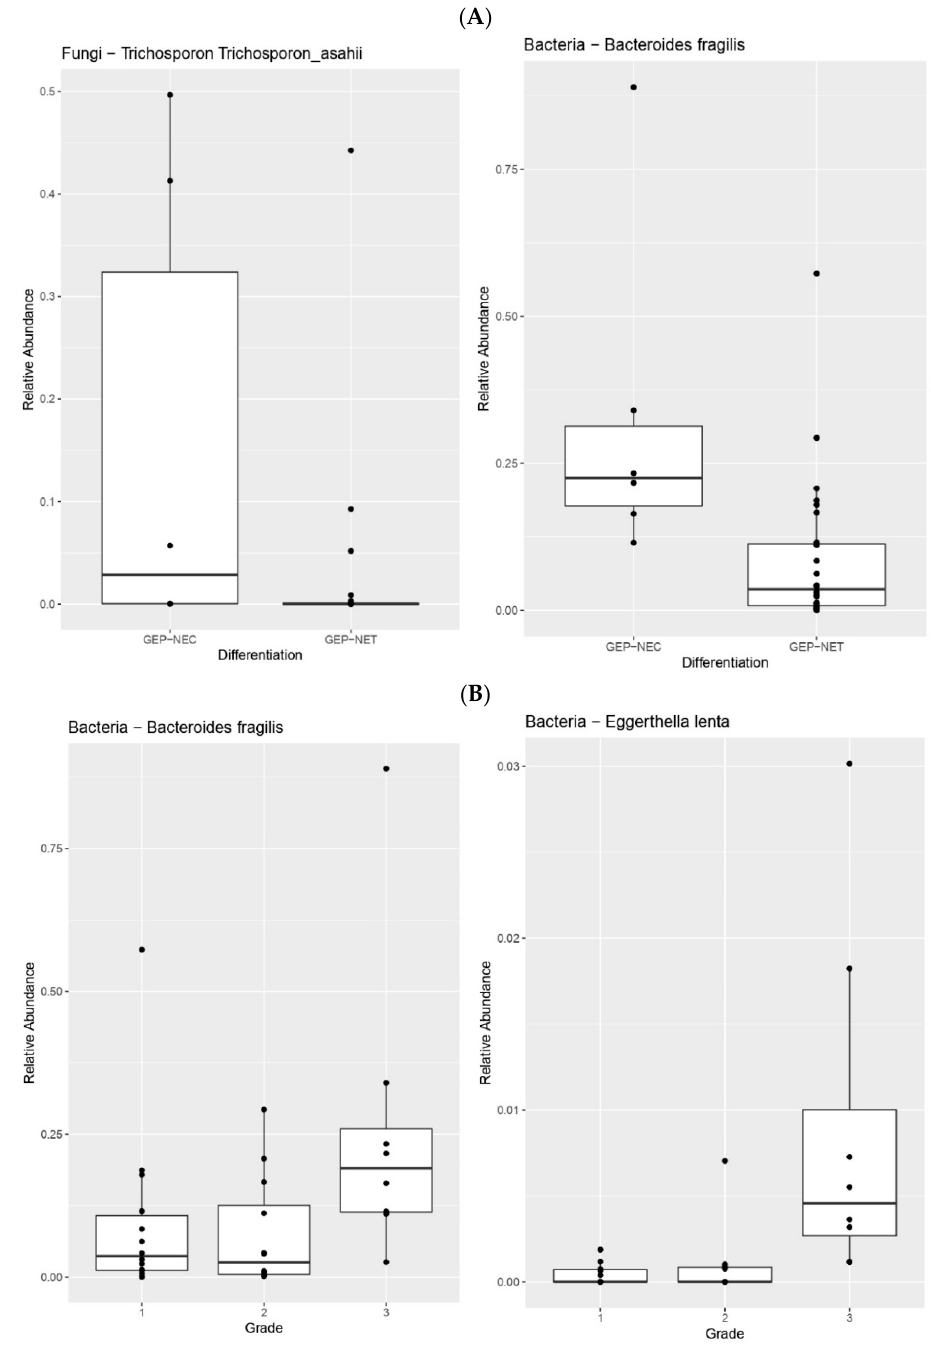
Figure 2. ( A ). Patients with GEP-NECs have significantly enriched bacteria and fungi ( Enterobacter hormaechei , Bacteroides fragilis , and Trichosporon asahii ) compared with patients who have GEP-NETs ( p = 0.048, 0.0022, and 0.034 respectively). ( B ). Higher grade (G3) GEP-NETs were associated with significantly higher Bacteroides fragilis ( p = 0.022) and Eggerthella lenta ( p = 0.00018) species compared to lower grade GEP-NETs (G1/2).